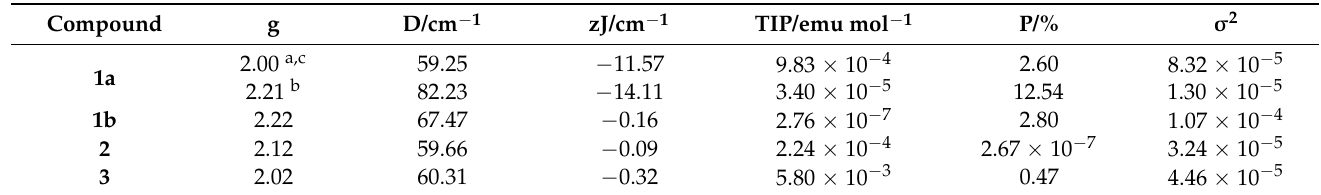
Table 4. Magnetic parameters obtained in the fits of the magnetic moment versus temperature curves for compounds 1 – 3 .